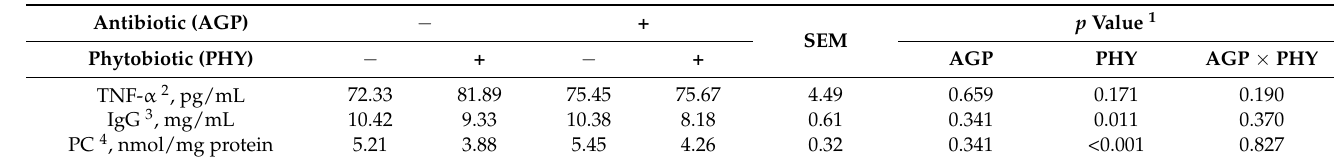
Table 6. Inflammatory response, humoral immunity, and oxidative stress in the plasma of growing pigs fed diets supplemented with phytobiotics and antibiotics as growth promoters (Exp. 2).